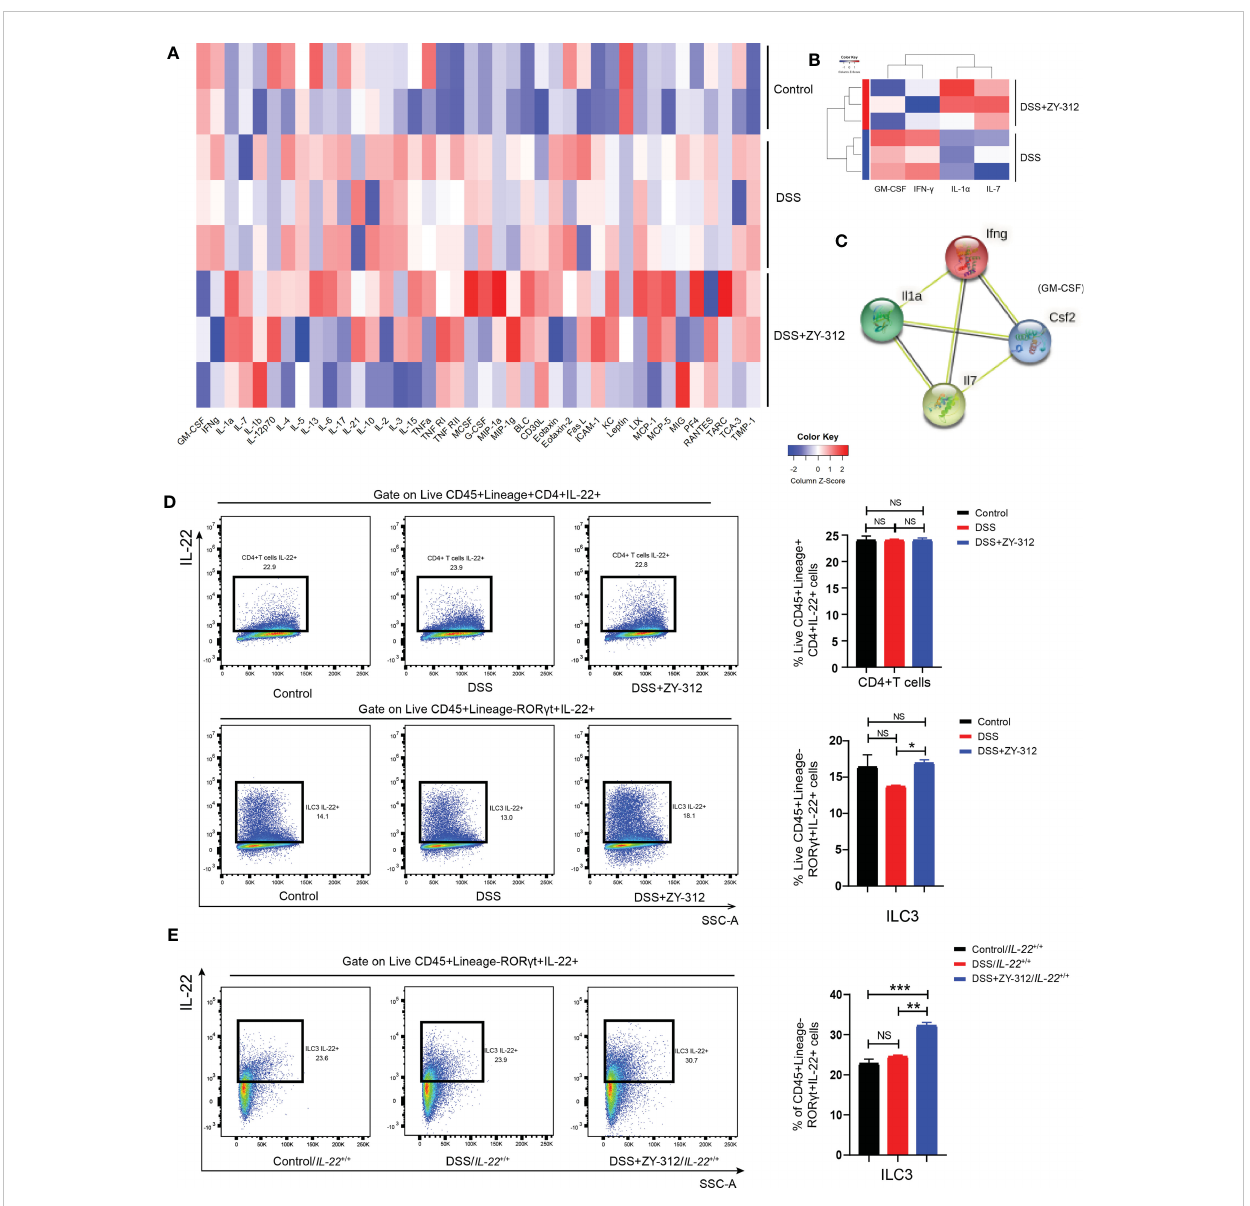
FIGURE 6 B. fragilis possibly promoted CLP-derived ILC3 to secrete IL-22 in DSS-induced colitis. (A) The heatmap analysis of in fl ammatory factors from colon tissue through protein microarray detection. Control group (N=2), DSS group (N=3), DSS+ZY-312 group (N=3). N, number of mice. Red represents up-regulation, and blue represents down-regulation. (B) The level of in fl ammatory factors including IL-7, IL-1 a , GM-CSF, and IFN- g showed signi fi cant differences between the DSS+ZY-312 group (N=3) and the DSS group (N=3). IL-7 (p value=0.0078), IL-1 a (p value=0.0038), GM-CSF (p value=0.0173), IFN- g (p value=0.0386), Red represents up-regulation, blue represents down-regulation. (C) The PPI (protein-protein interaction) analysis of DEGs (differentially expressed genes) between the DSS group and DSS+ZY-312 group. Network nodes represent proteins, edges represent protein-protein associations, colored nodes: query proteins and the fi rst shell of interactors, white nodes: the second shell of interactors, and empty nodes: proteins of unknown 3D structure, contrary to a known 3D structure. (D) IL-22 secreting ILC3 (labeled with FVS-CD45+Lineage-ROR g t+IL-22 +) and CD4+T cells (labeled with FVS-CD45+Lineage+CD4+IL-22+) from CLP in C57BL/6 mice were analyzed by cell fl ow cytometry, and statistical analysis of cell percentage was showed (right panel). Control group (N=3), DSS group (N=13), DSS+ZY-312 group (N=11). N, number of mice. (E) Cell fl ow cytometry analysis of IL-22 secreting ILC3 in IL-22 +/+ mice. Control group/ IL-22 +/+ (N=3), DSS group/ IL-22 +/+ (N=3), DSS+ B. fragilis group/ IL- 22 +/+ (N=3). N, number of mice. Data are presented as Mean ± SEM. Statistical analysis was performed using one-way ANOVA (D, E) . * p < 0.05,** p < 0.01, *** p < 0.005, NS indicates no signi fi